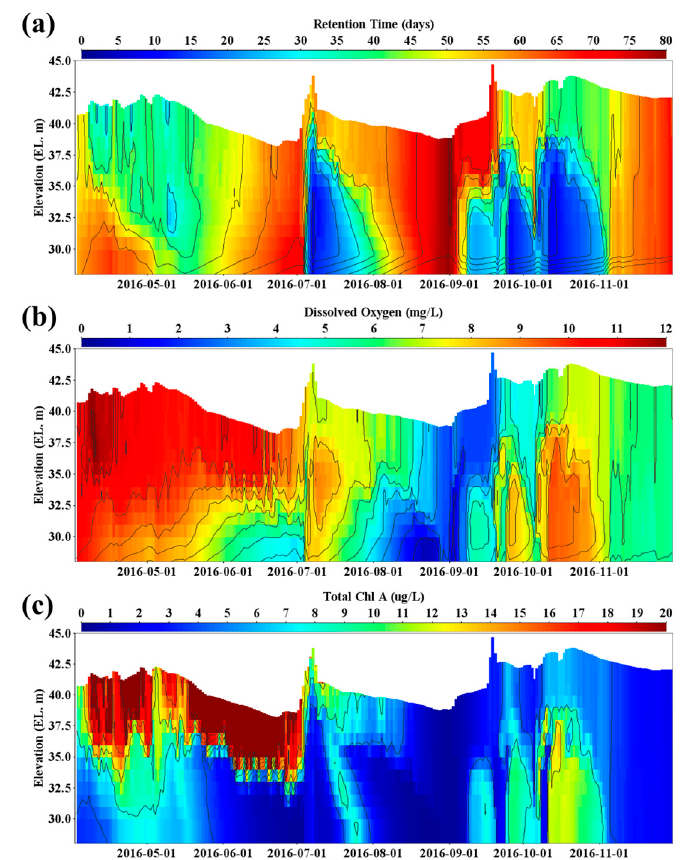
Figure 9. Temporal isopleth of vertical water quality in front of the Namgang dam (S2): ( a ) retention time, ( b ) DO, ( c ) chlorophyll-a.